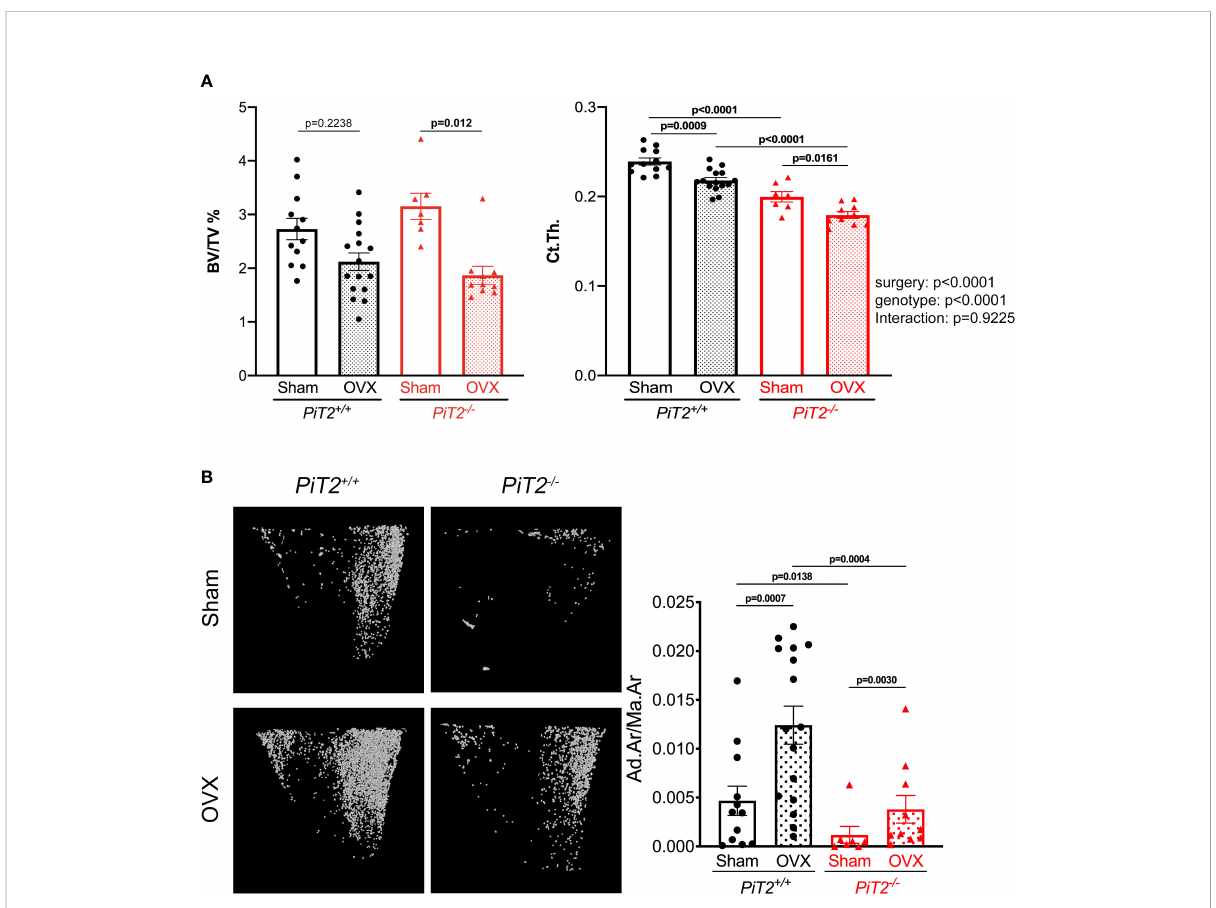
FIGURE 3 PiT2 de fi ciency does not prevent BMAT volume increase and bone mass loss after ovariectomy. (A) Bone volume/tissue volume (BV/TV, left ) and cortical thickness (Ct.th., right ) of tibia from shame operated mice (n=12 PiT2 +/+ and n=7 PiT2 -/- ) or after ovariectomy (OVX, n=16 PiT2 +/+ and n=10 PiT2 -/- ) quanti fi ed using CE-CT images. Data are means ± SEM, Bonferroni-corrected Mann-Whitney test (BV/TV) and two-way ANOVA test (Ct.Th.) For Ct.Th., the in fl uence of surgery or genotype, and interactions between these, was determined by two-way ANOVA, with p values shown to the right of the graph. p values from multiple comparisons are indicated on the graphs (B) Left: representative 3D visualization, using Hf-POM-based CE-CT, of adipocytes in the bone marrow compartment of the proximal tibia (2mm height from the growth plate) of PiT2 +/+ and PiT2 -/- female mice after ovariectomy (OVX). Right : graphs showing the quanti fi cation of the volume fraction of the adipocytes in the VOI of the proximal tibia (Ad.Ar/Ma.Ar: Adipocyte area/Marrow Area) in shamed operated mice (n=12 PiT2 +/+ and n=7 PiT2 -/- ) or after ovariectomy (OVX, n=16 PiT2 +/+ and n=10 PiT2 -/- ). Data are means ± SEM, Bonferroni-corrected Mann-Whitney